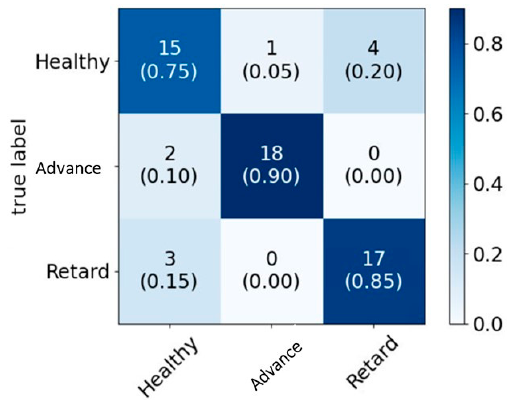
Figure 13. Model 3—confusion matrix for ignition timing variation data.